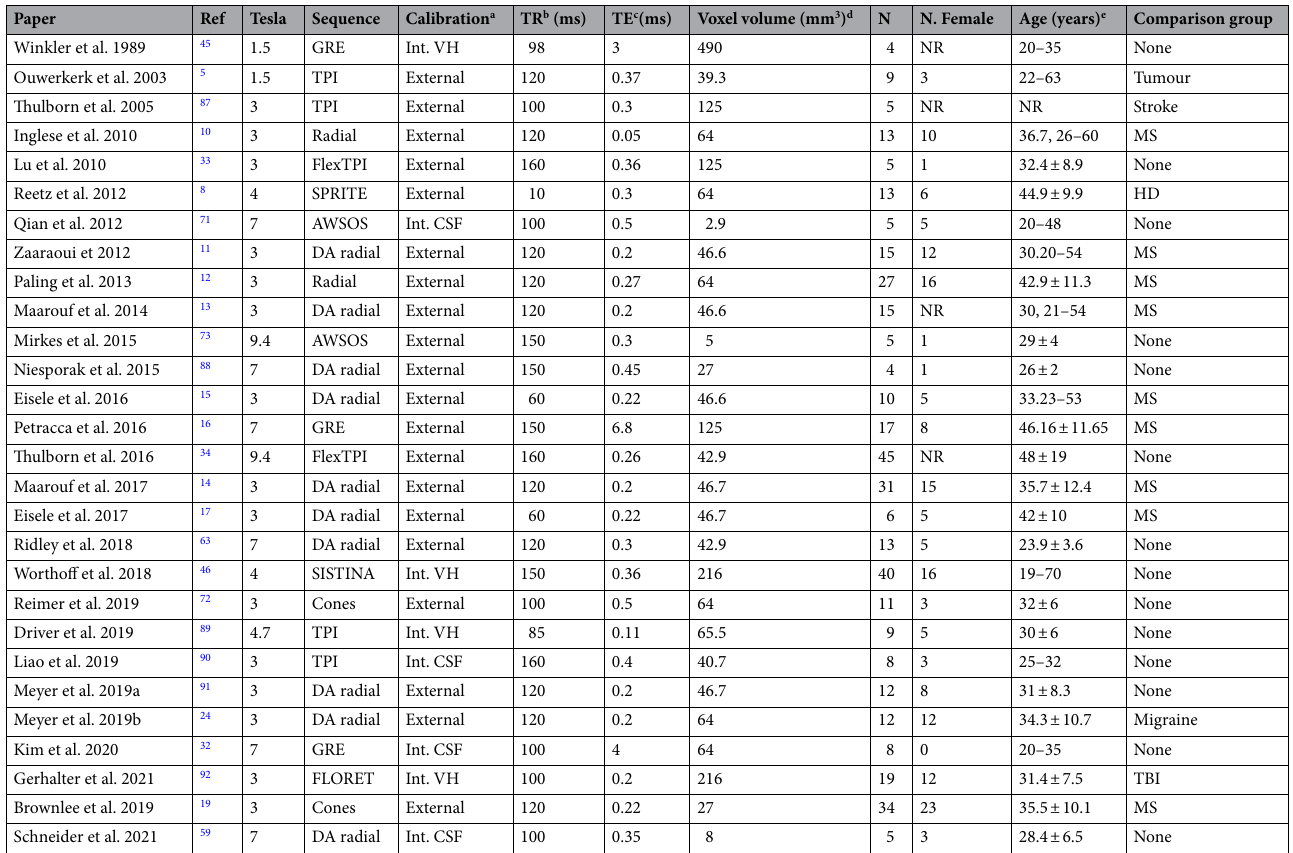
Table 1. Characteristics of included studies. a Int . internal, Ext . external, CSF cerebrospinal fluid, VH